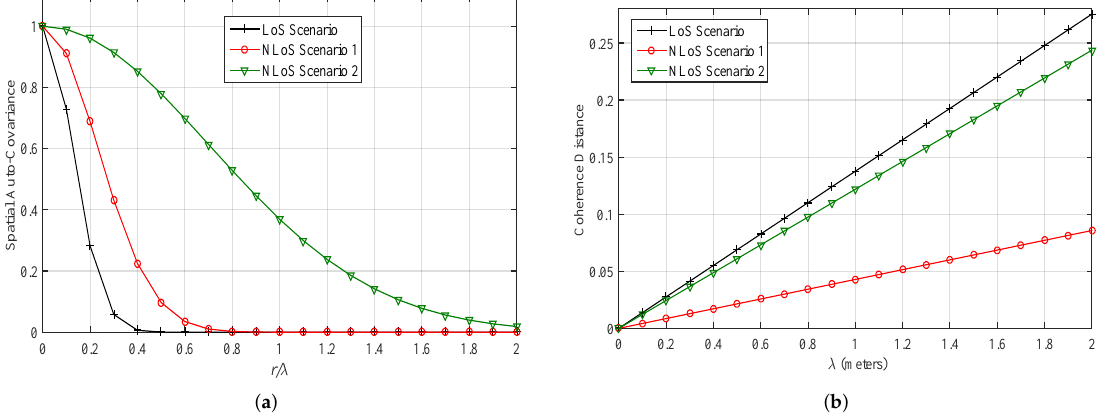
Figure 11. Spatial auto-covariance and CD for different scenarios of indoor mmWave (Case 3; 28 GHz) radio propagation environments in ( a , b ), respectively. ( m = 4 for LoS Scenario and m = 1 for NLoS Scenarios, f d = 10